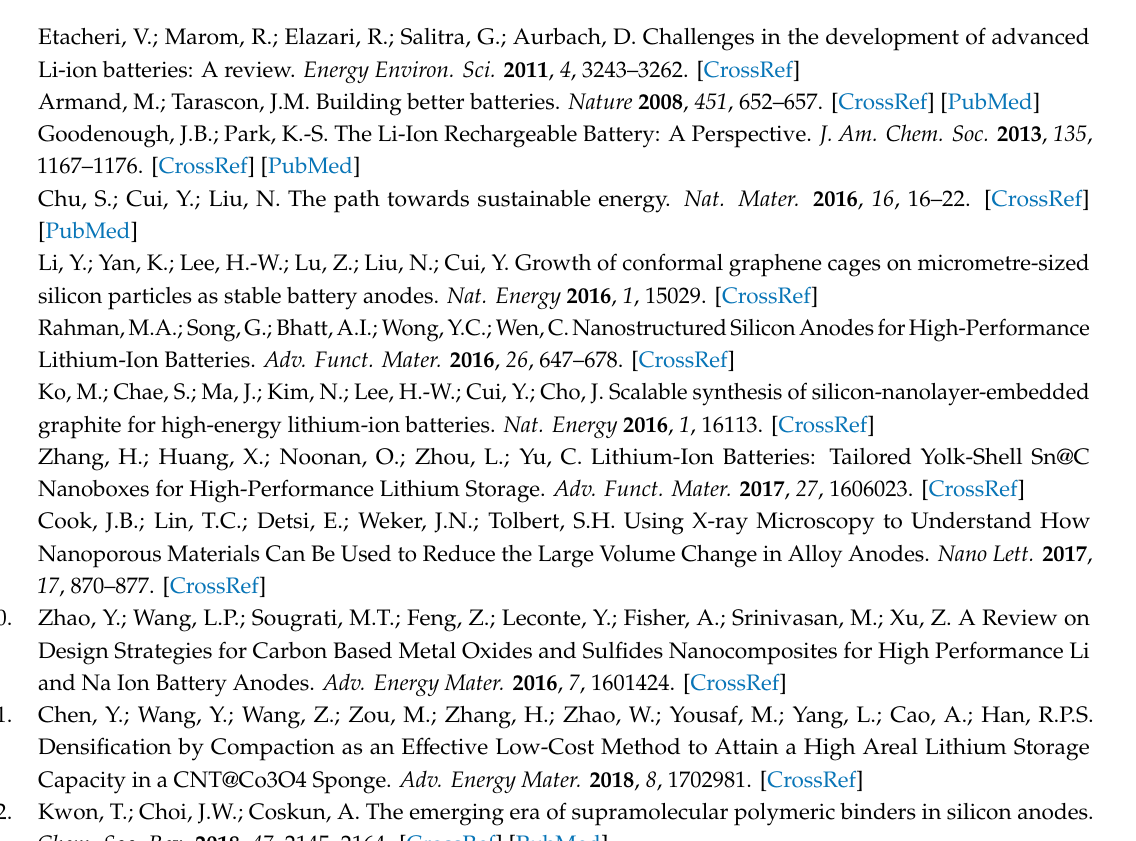
Figure S1: Digital photo images of (a) iron (III) p-toluenesulfonate hexahydrate (IPTH) precursor and (b) FeS@C particles from IPTH annealed at 700 ◦ C, Figure S2: TG and DTG curves of iron(III) p-toluenesulfonate hexahydrate under Ar atmosphere with a ramp rate of 5 ◦ C min -1 , Figure S3: Digital photo images of FeS@C particles before (a) and after (b) pyrolysis at 700 ◦ C, Figure S4: SEM images of FeS@C-700 particles at increasing magnification, Figure S5: Raman spectrum of FeS@C-700 particles, Figure S6: (a) Nitrogen adsorption / desorption isotherms and